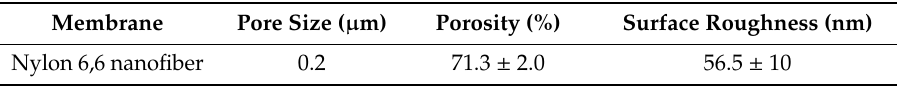
Table 1. Properties of the nylon 6,6 nanofiber